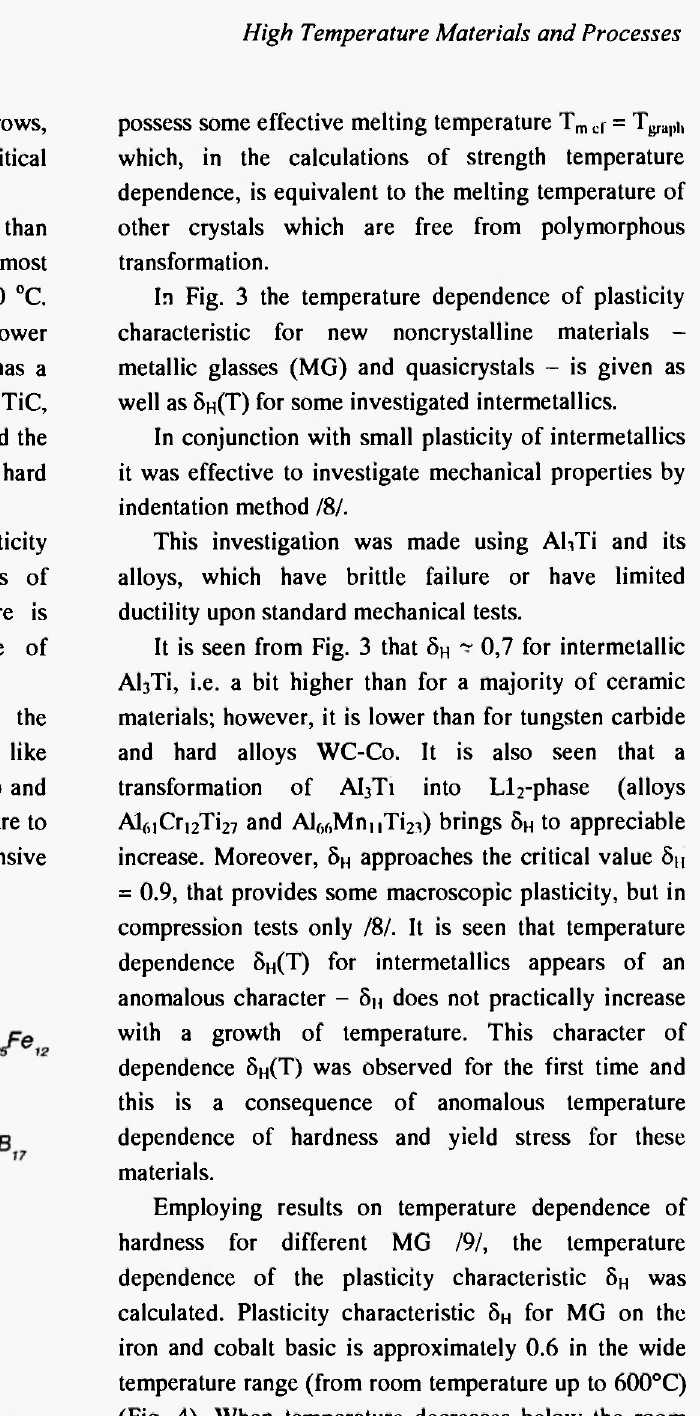
Fig. 3: Temperature dependence of δ Η for materials with different type of interatomic bonds and atomic